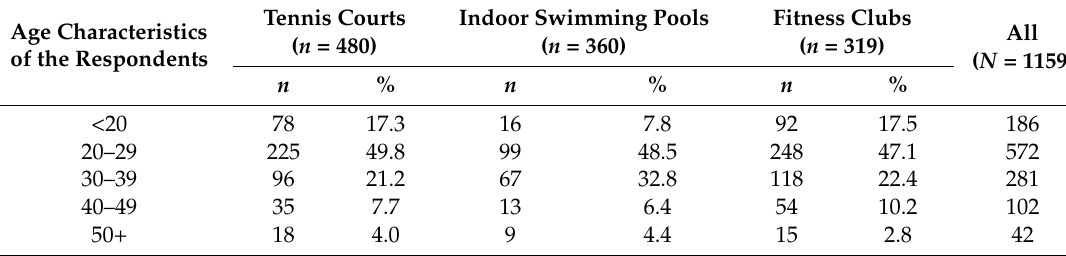
Table 1. Characteristics of respondents.